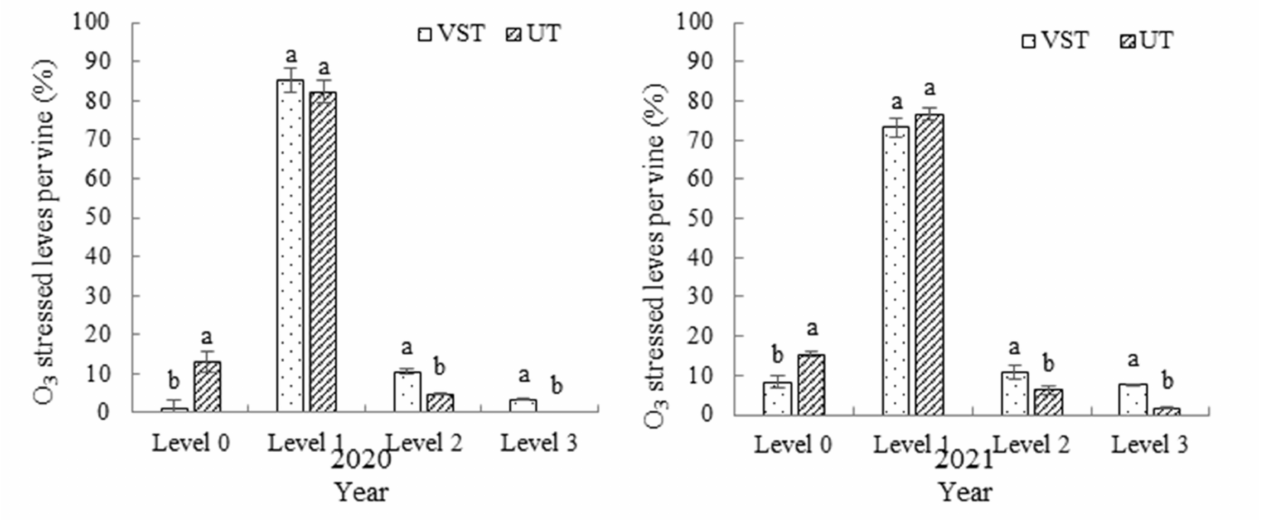
Figure 5. Effects of different canopy types on ozone injury symptoms in grape leaves. Values are the mean of three replicates and error bars denote the SD. Different lowercase letters indicate significant differences based on Duncan’s multiple range test ( p <